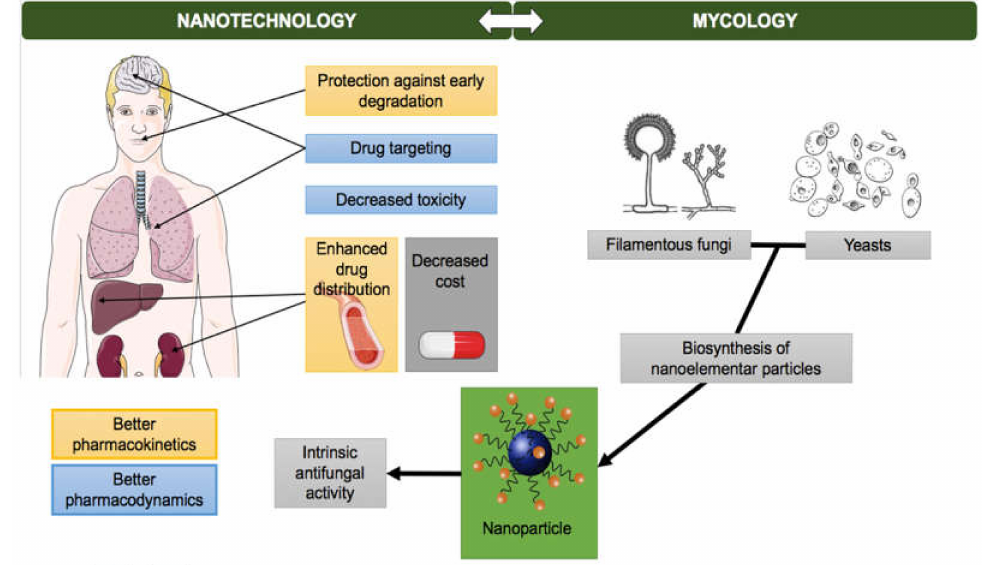
Figure 2. Bidirectional relationship of Nanoparticles and Mycology: nanotechnology has proven to be useful in improving antifungals pharmacokinetics and pharmacodynamics and many fungi have been used to biologically synthetize